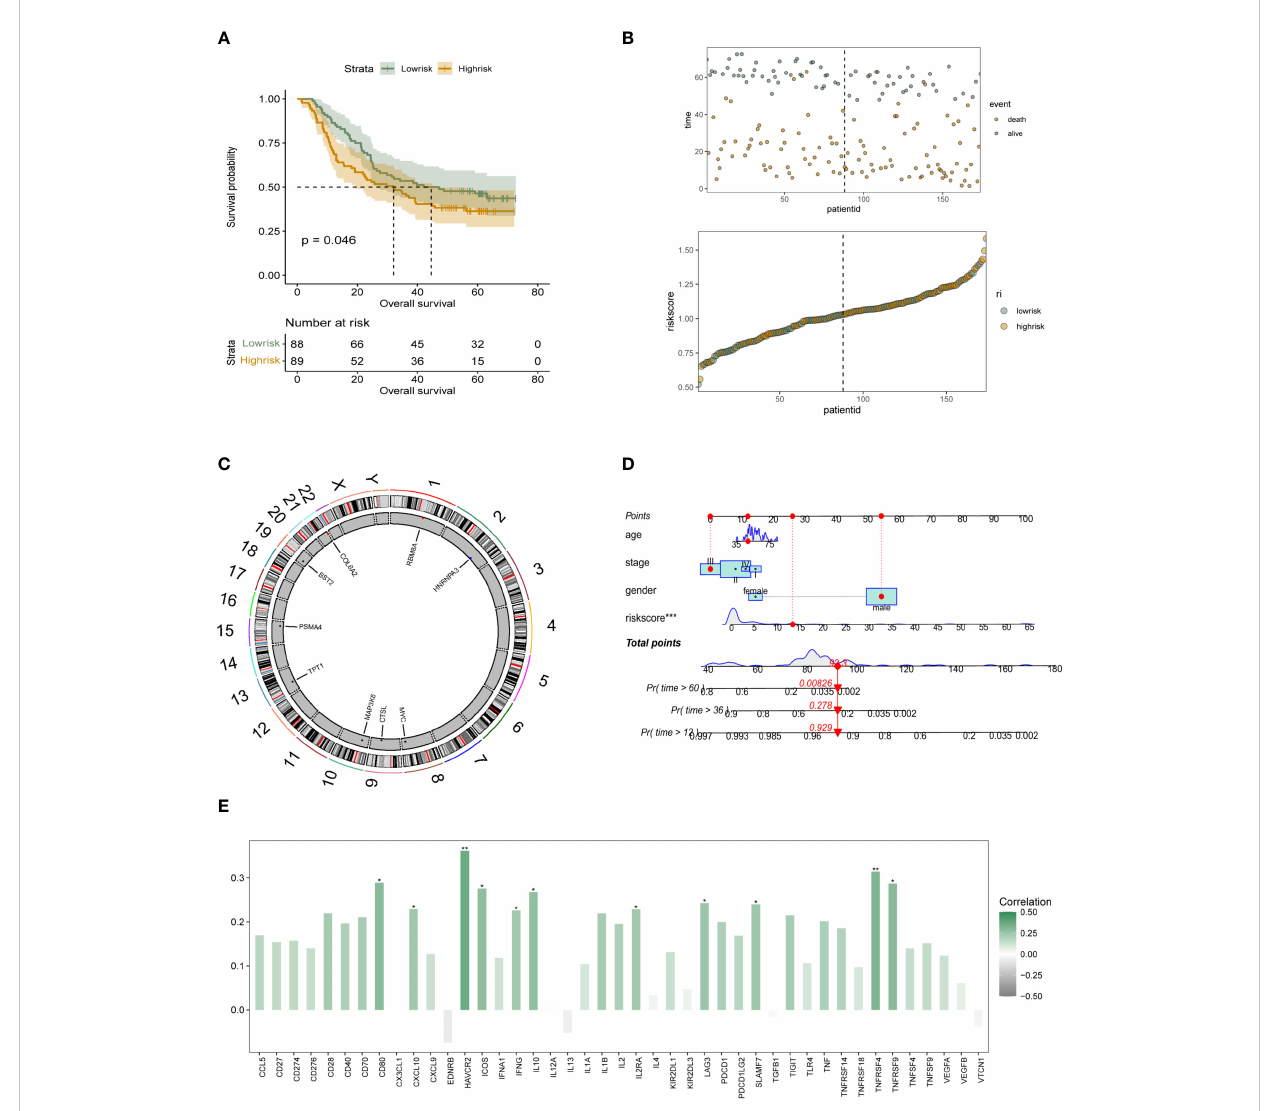
FIGURE 4 Independent validation and initial immune-related characterization of the survival risk model for m6A epigenetics (A) K-M analysis in GEO ’ s independent validation database reveals the prognostic strati fi cation ability of the constructed m6A epigenetic-associated riskscore for patients in the high-risk and low-risk groups, respectively; (B) Dotted line and scatter plots reveal the survival time and survival status of ESCC patients with different riskscore, from left to right, representing the riskscore of high and low variation, and the scatter colours represent survival and death status; (C) Chromosomal expression location map of m6A genes constituting the risk model; (D) Nomogram based on m6A riskscore reveals the prognostic strati fi cation score of ESCC patients; (E) Bar graphs initially show the potential association between m6A epigenetic and tumor immune in fi ltration- related proteins. * means <0.05, ** means <0.01, *** means